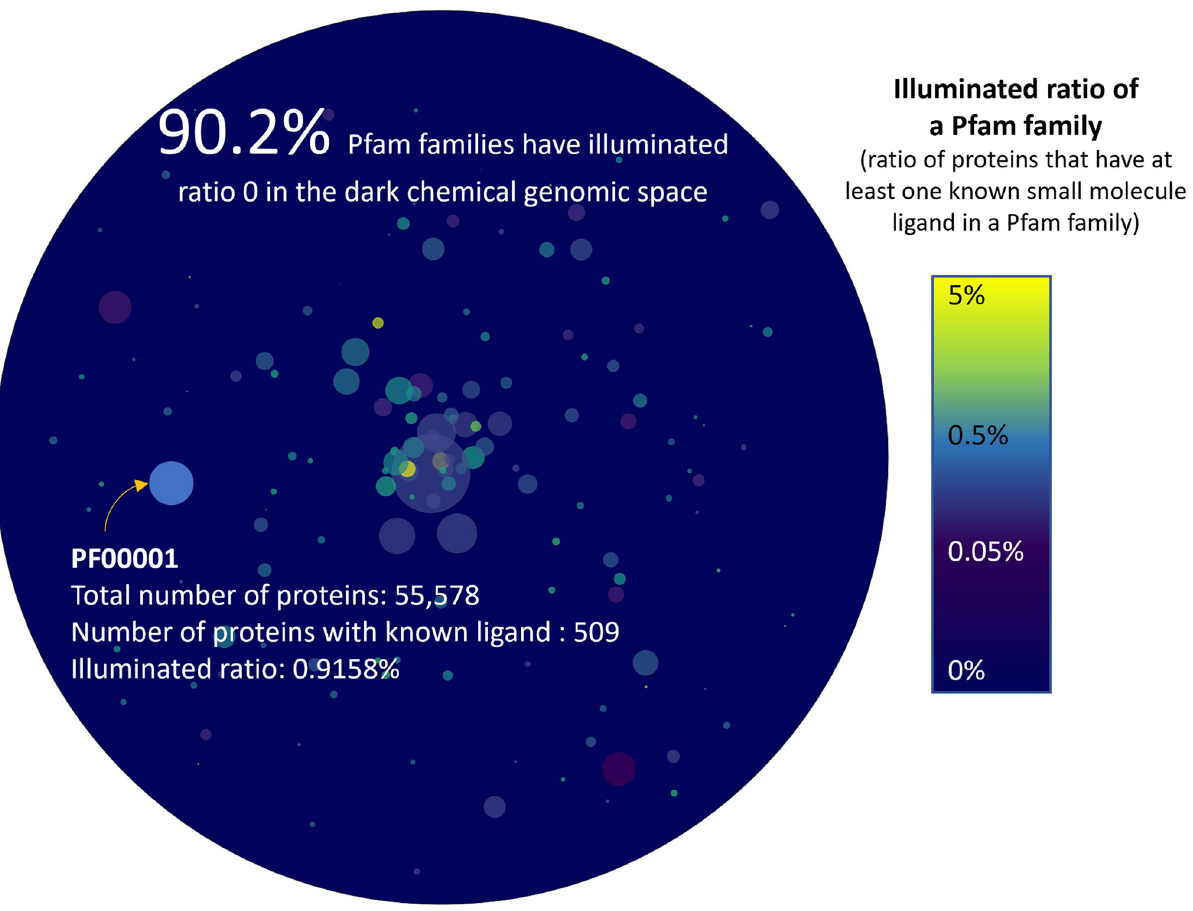
Fig 2. Dark protein space in terms of statistics. The fraction of proteins that have at least one known ligand in each Pfam family is graphically represented here. Each color bubble indicates a Pfam family, and the size of the bubble is proportional to the total number of proteins in that family. 1, 734 Pfam families have at least one known small molecule ligand. One can see that most Pfam families have less than 1% proteins with known ligands. Furthermore, around 90.2% of the total 17, 772 Pfam families remain completely dark, without any known ligand-binding information. These “dark regions” represent a vast untapped resource in drug